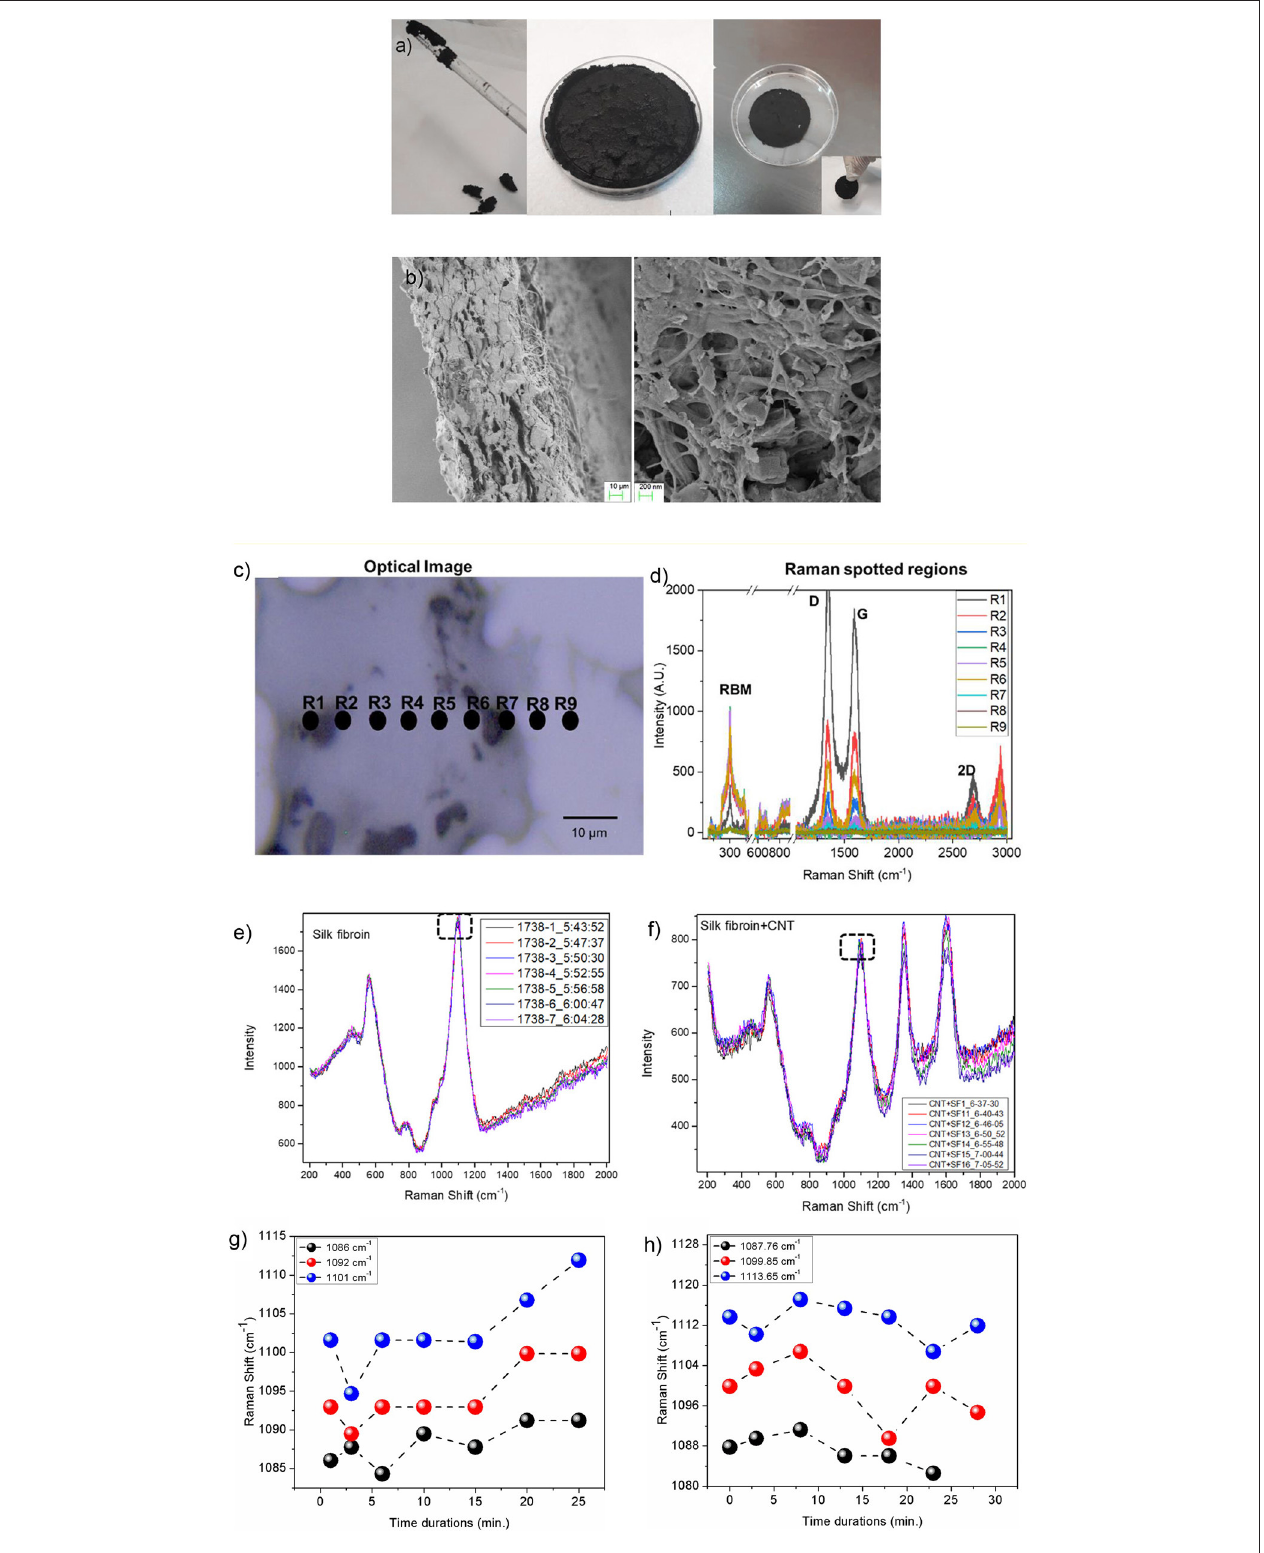
FIGURE 3 | (a) The CNTs in RS solution can be processed to obtain a dough. Once annealed, the RS/CNT dough shows a contraction and can be taken by hands as a freestanding solid sample. (b) Morphology of RS/CNTs dried sample in FESEM showing well separated CNTs after being processed in RS. (c) Optical image